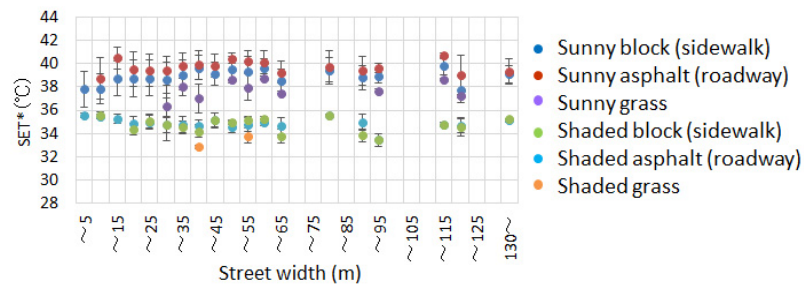
Figure 16. Relationship between street width and SET* at 1.5 m height at 1:00 p.m. on 5 August 2019 on north-south road. The plot is the averaged value, and the vertical bar on each plot is the standard deviation in the street width section.